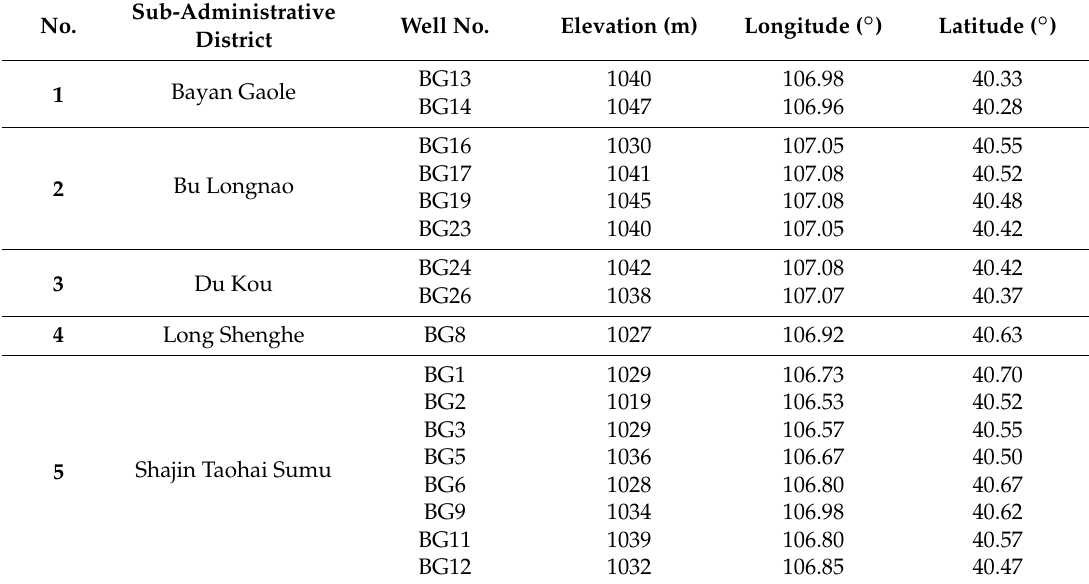
Table 1. Well numbers under different sub-administrative districts of Denko County used for the